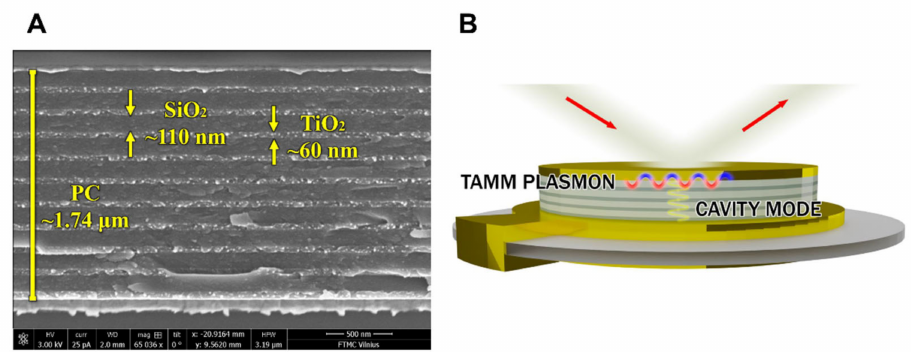
Figure 2. SEM micrograph of the modified QCM-D sensor chip ( A ) and a scheme illustrating formation of BSA and anti-BSA proteins on a modified QCM-D ( B